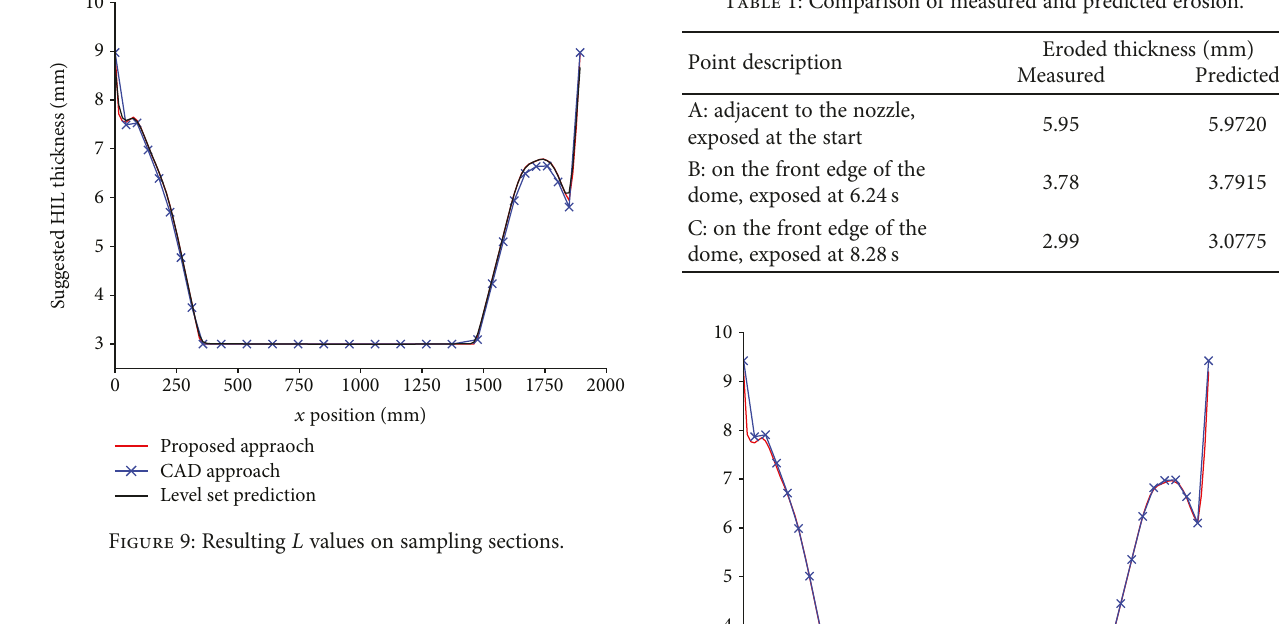
Table 1: Comparison of measured and predicted erosion.